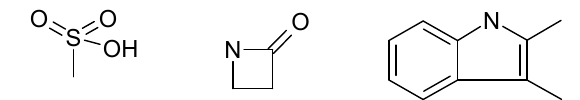
Figure 2. Toxicophoric features identified from the Tox21 dataset by the neural network